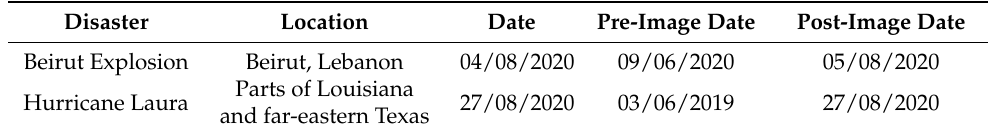
Table 3. The two disasters’ detail